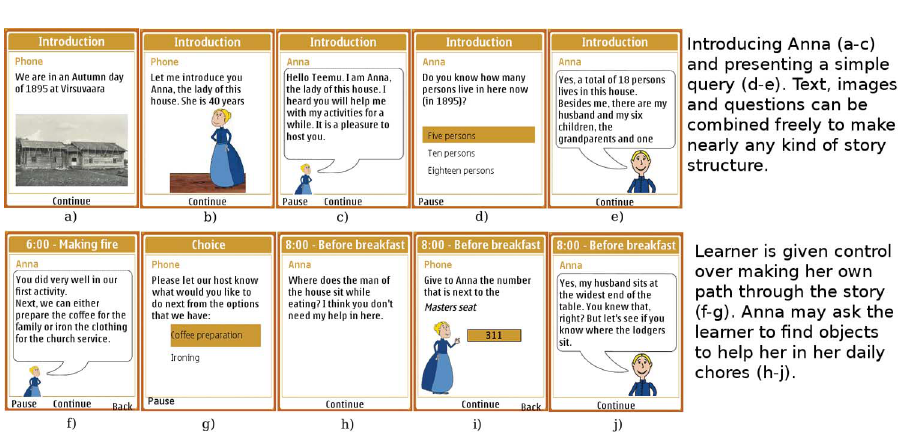
Figure 3. Conversation with Anna in